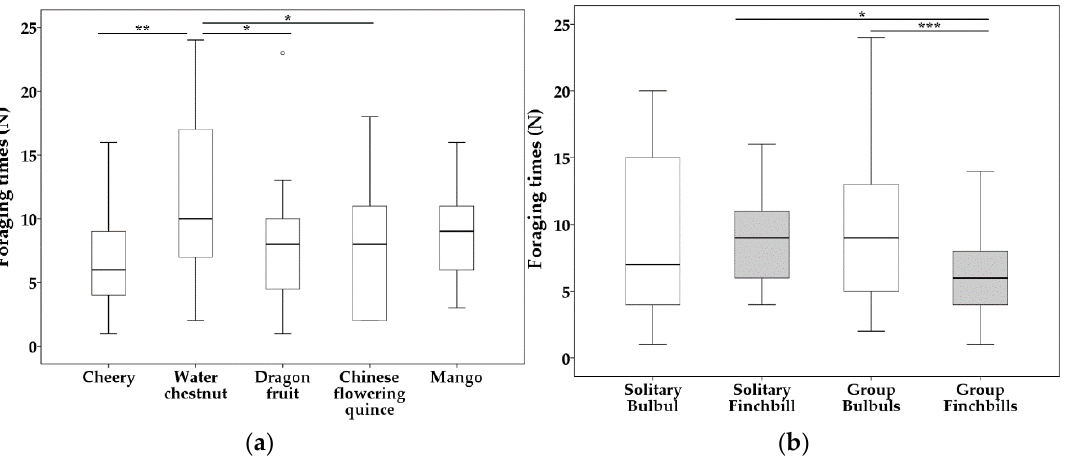
Coefficients and 95% confidence intervals (CI) are presented; statistically significant comparisons (zero is not included in the interval) are in bold. p - values were obtained with Tukey’s method ad justed for multiple comparisons. “Individual identity” was fitted as a random effect , with associated variance shown. Food type: (a) cherry, (b) water chestnut, (c) dragon fruit, (d) Chinese flowering quince, and (e) mango.